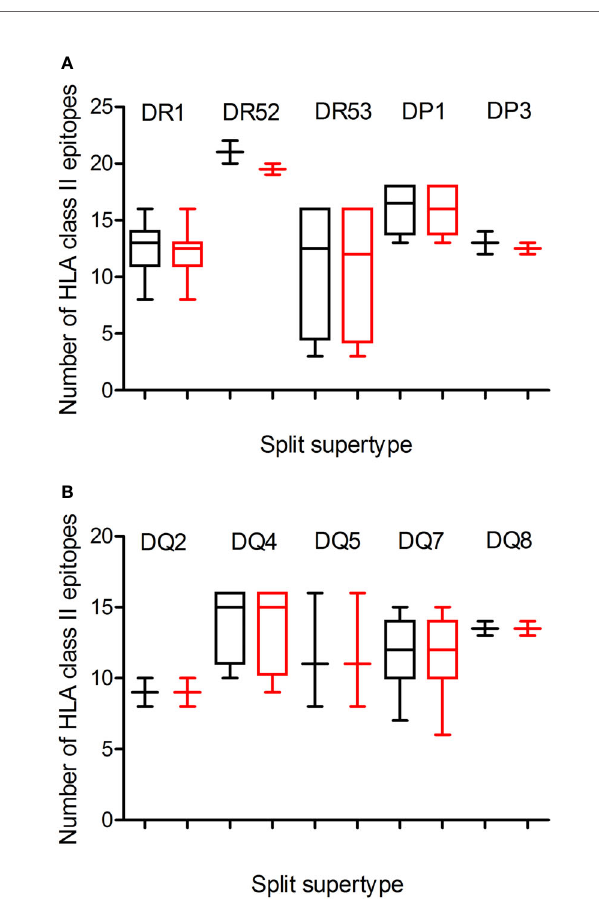
FIGURE 2 | Average number of epitopes in the Wuhan-1 and Omicron spike protein sequences predicted for HLA class II alleles including in the 10 HLA class II supertypes. The median value is indicated. Box limits indicate the interquartile range. Whiskers are adjusted to maximal and minimal values. The number of epitopes in the Wuhan-1 (black) and Omicron (red) strains predicted for HLA class I alleles including in the 3 HLA-DR and -DP or 5-DQ supertypes are depicted in panels (A, B) ,